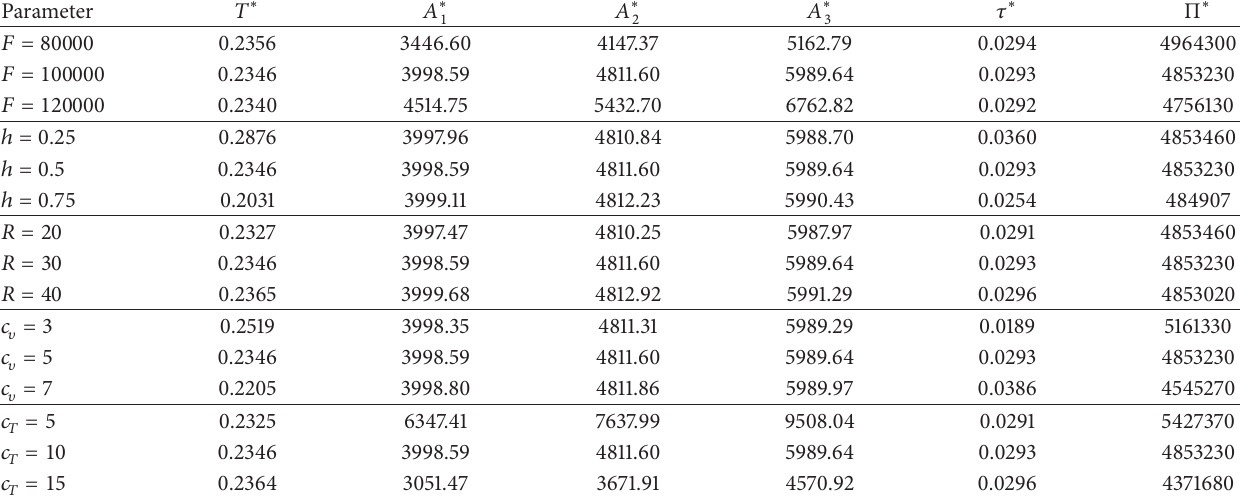
Table 1: Effects of different system parameters.